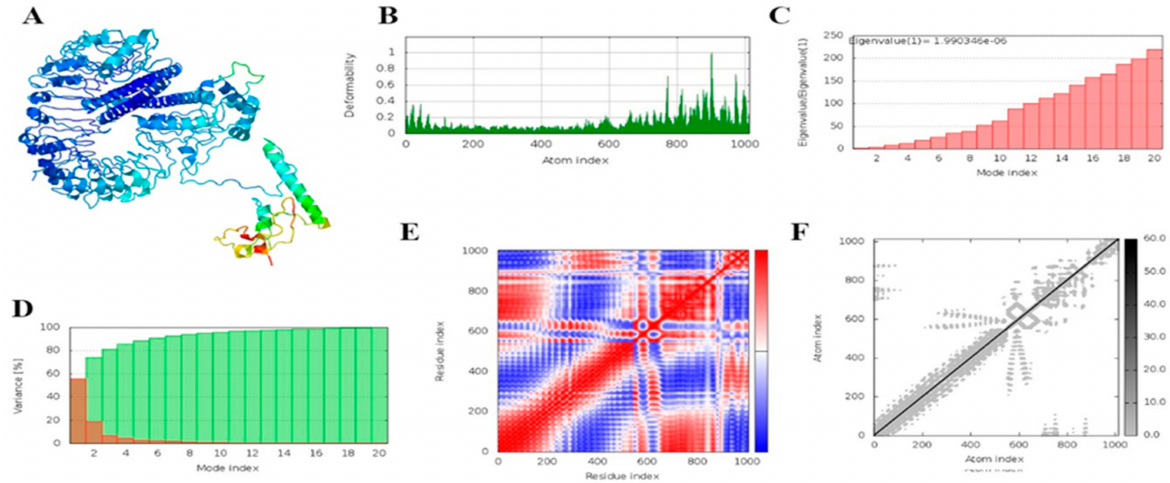
Figure 12. Outcomes of MD simulations of TLR-2 and the designed vaccine construct. ( A ) NMA mobility; ( B )deformabilityplot; ( C )eigenvalueplot; ( D )varianceplot(individualvariancesarered, whilecumulative variances are green); ( E ) covariance map [correlated (red), uncorrelated (white), or anti-correlated (blue) motions]; ( F ) elastic network (darker grey regions indicate stiffer regions) of the complex.